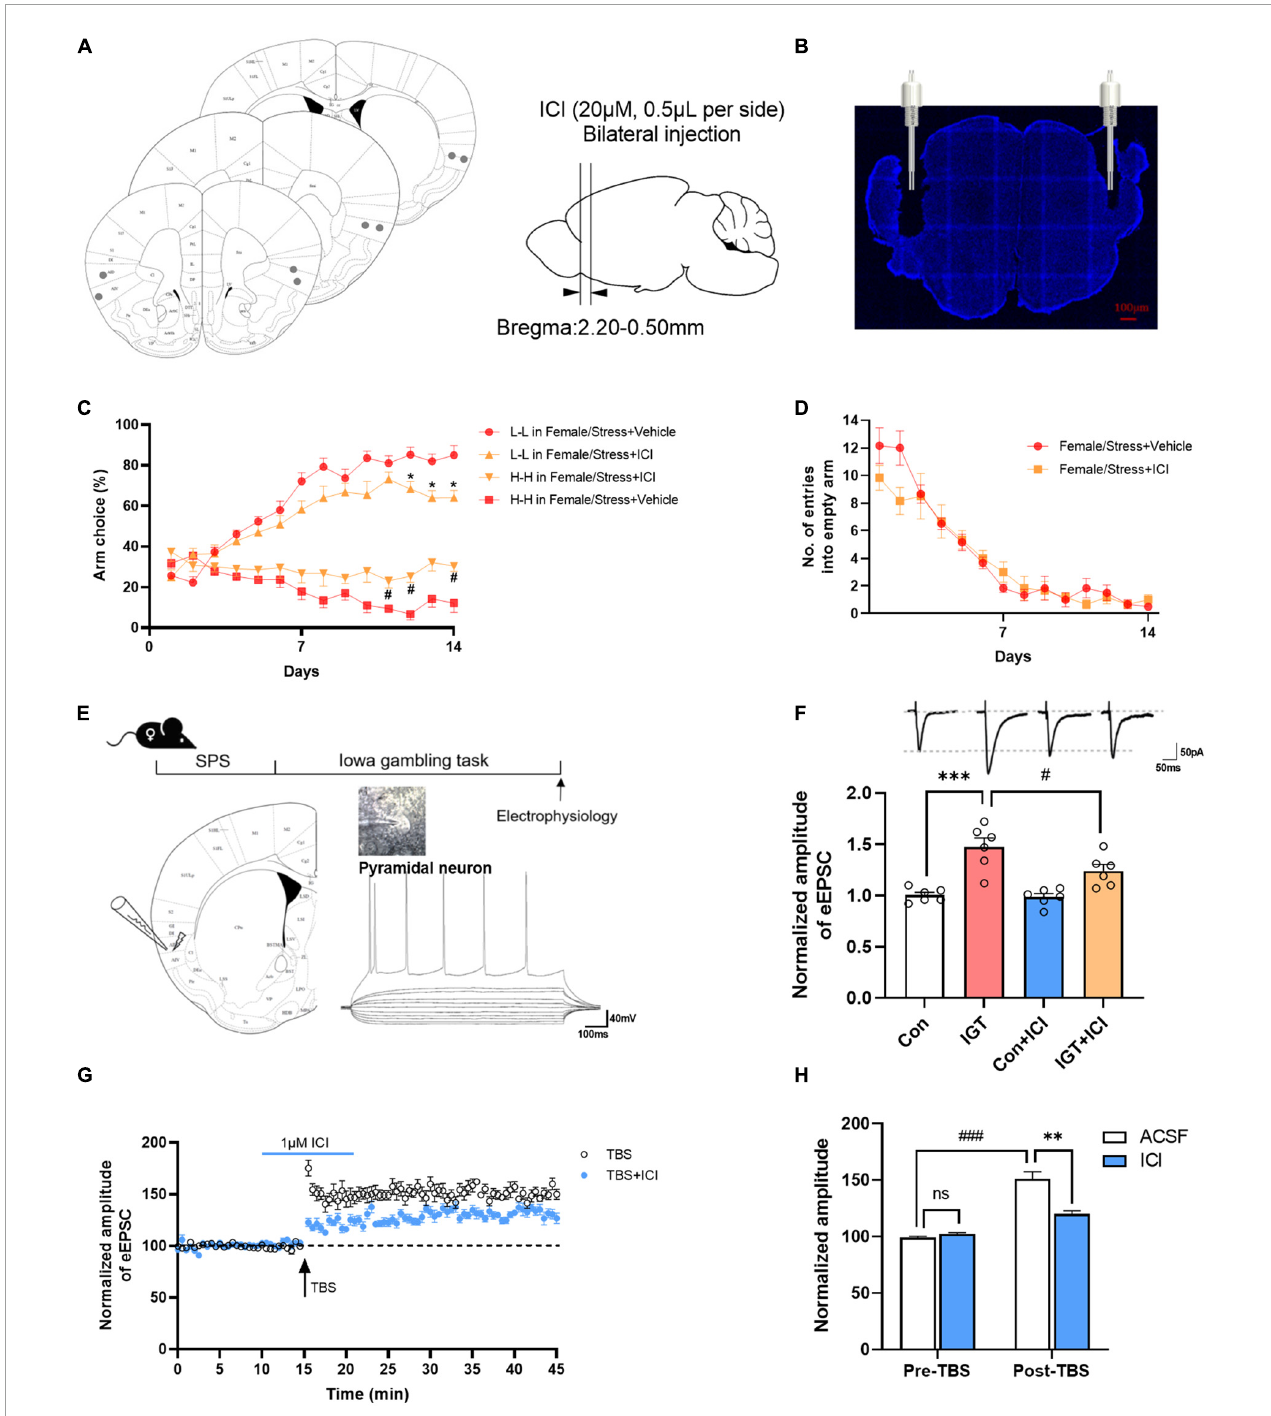
FIGURE5 Endogenous estrogen in the AIC contributes to decision-making and synaptic plasticity. (A,B) Photograph of coronal section and histological reconstruction of microinjection sites in the bilateral AIC. (C) Effect of ICI 182, 780 (ICI) on decision-making task of female mice after stress. Repeated-measures ANOVA with Bonferroni correction. ∗ P < 0.05 vs. the L-L arm choice in the female/stress vehicle group ( post-hoc Tukey’s test, P = 0.0379 on day 12, P = 0.0203 on day 13, P = 0.0250 on day 14), # P < 0.05 vs. the H-H arm choice in the female/stress vehicle group ( post-hoc Tukey’s test, P = 0.0450 on day 11, P = 0.0051 on day 12, P = 0.0341 on day 14). (D) Number of entries into empty arms. (E) Diagrams indicating the placement of the stimulating and recording electrodes in the AIC. (F) The effects of perfusion of ICI on EPSCs in control (female mice without stress)